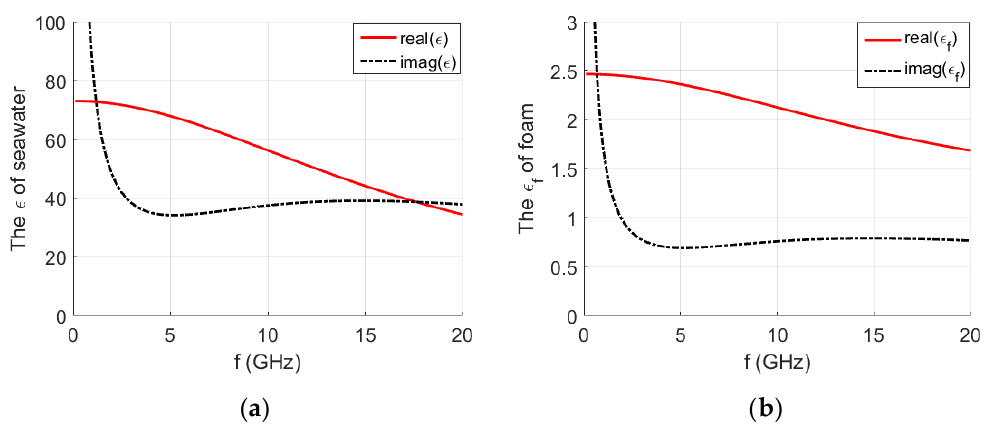
Figure 5. ( a ) The dielectric constant of seawater. ( b ) The dielectric constant of sea surface covered with foam.